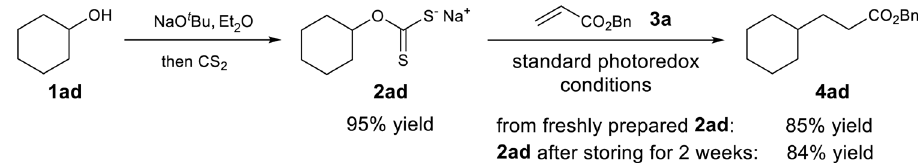
Fig. 5 Preparation and reaction of xanthate salts. Deoxygenative alkylation of alcohols performed in steps.